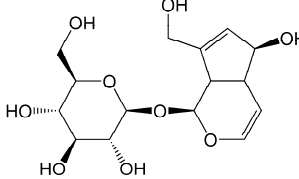
Figure 1. The molecular structure of aucubin.